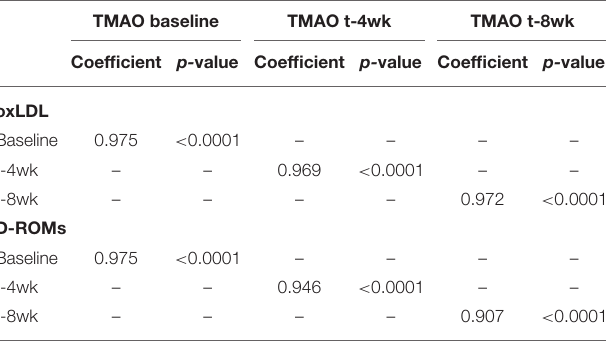
TABLE 6 | Correlation analysis between TMAO, oxLDL, and D-ROMs serum levels in all study participants.